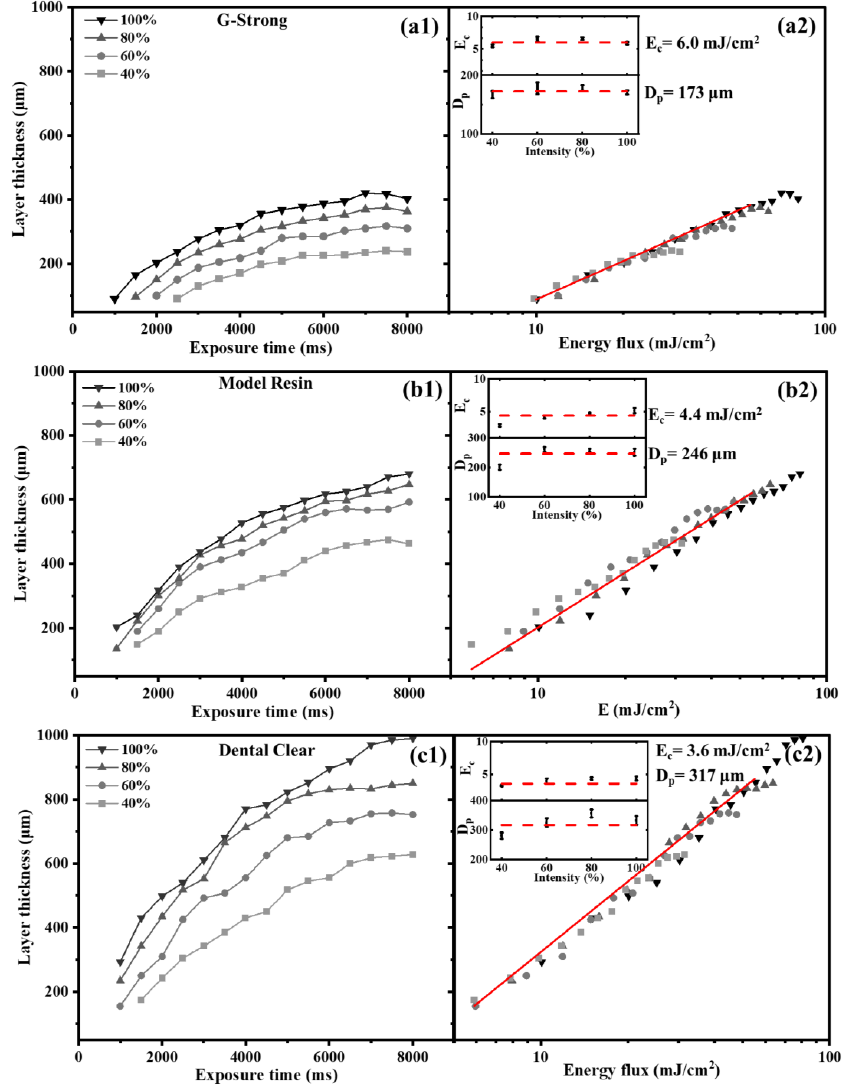
Figure 4. Monolayer film thickness as a function of exposure time at different light intensities ( a1 , b1 , c1 ) and as a function of radiated energy flux ( a2 , b2 , c2 ), for determination of critical energy (E c ) and penetration depth (D p ) of pure resins: G-Strong ( a1 , a2 ), Model Resin ( b1 , b2 ) and Dental Clear ( c1 , c2 ).